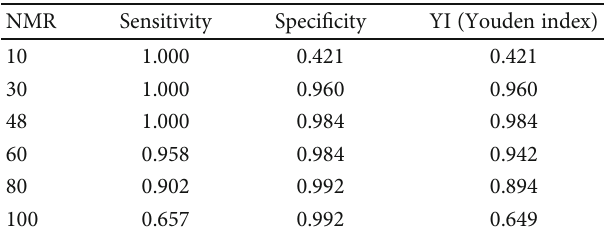
Table 3: Results of diagnostic indicators at di ff erent cuto ff values of NMR.